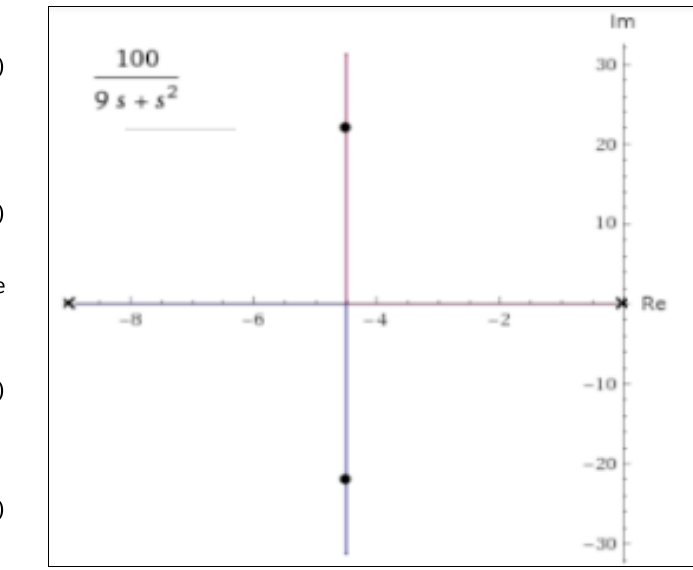
Figure 5: Root locus for uncompensated